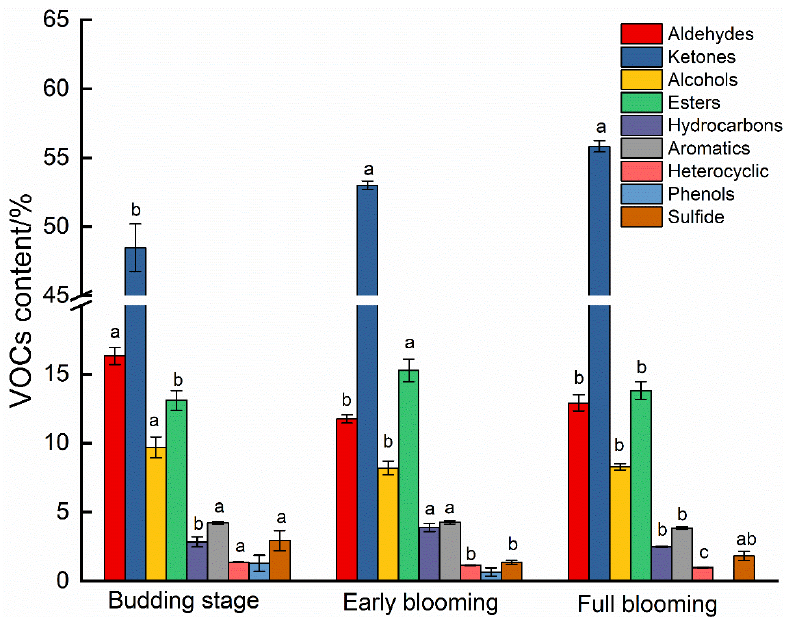
Figure 1. Changes in VOCs content of alfalfa at harvest-reaping periods. Different lowercase letters indicate significant difference at p < 0.05.